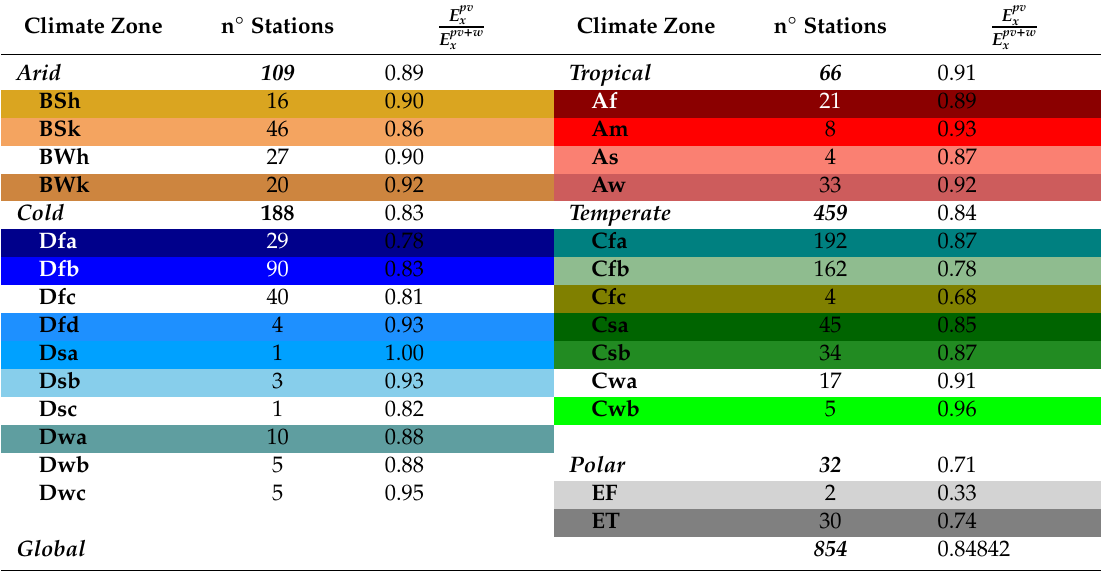
Table 6. PV contribution to the PV + W hybrid-facility generation. (See Figure 4 for climate zone codification).